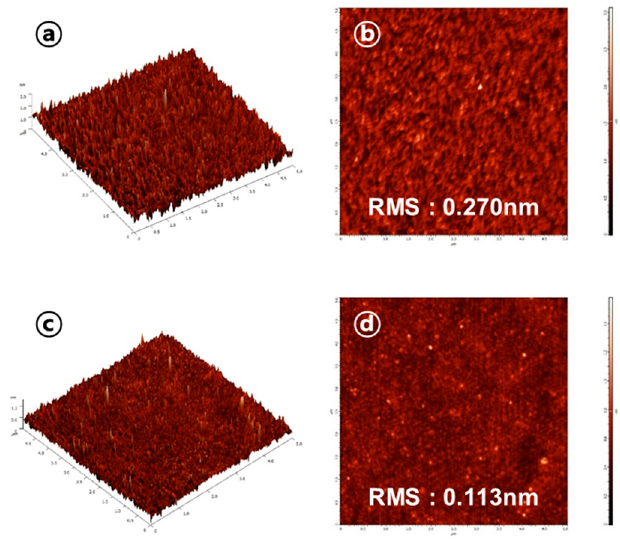
Figure 7. Atomic force microscopy analysis of CMEN-Zr-based ZrO 2 thin films. ( a , b ) ALD-deposited ZrO 2 thin films (deposition temperature: 150 °C, CMEN-Zr pulse time: 2.5 s, O 2 plasma pulse time: 9 s, PEALD cycle: 300 cycles (~27 nm)), ( c , d ) Si substrate: P-type silicon.